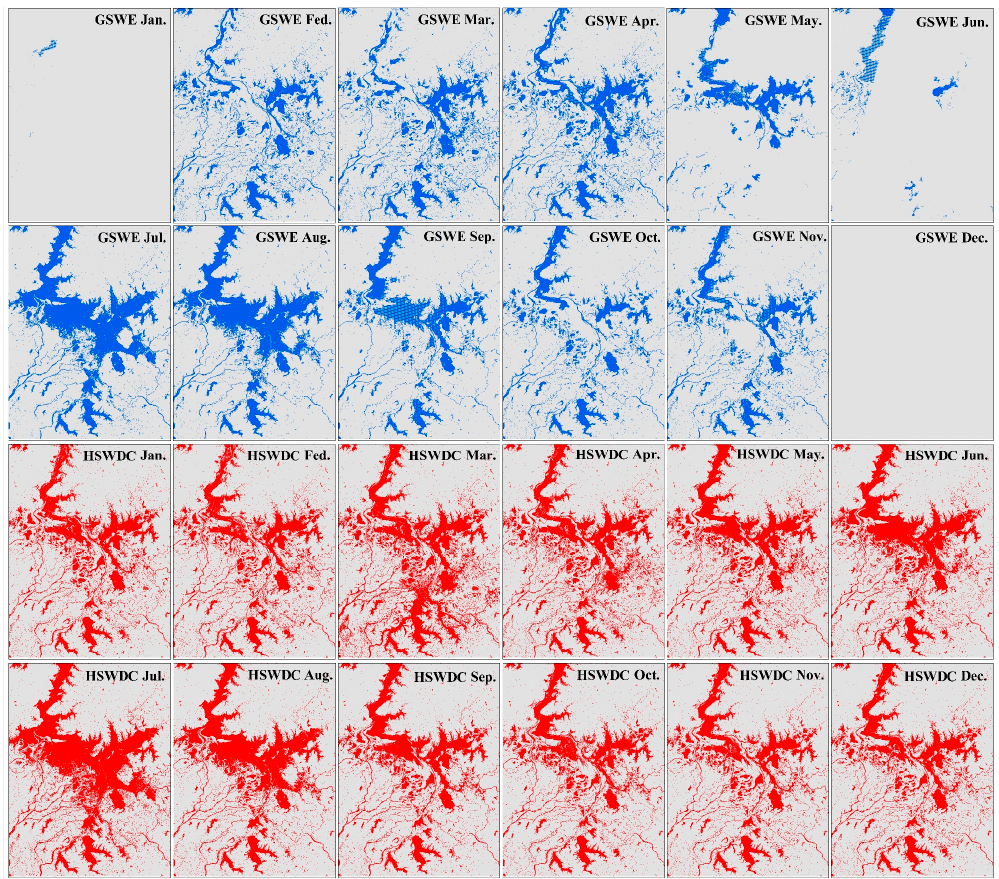
Figure 6. Comparison of monthly water dynamics of Poyang Lake during 2018 based on the GSWE dataset (blue) and the HSWDC dataset (red).